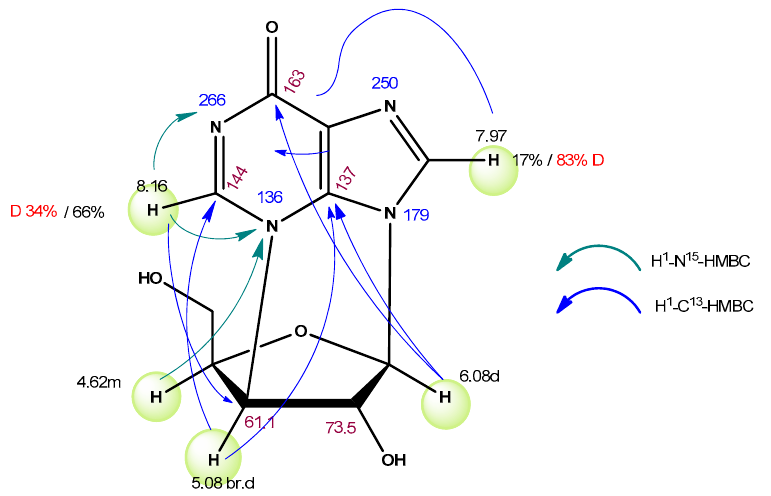
Figure 10. Assignments of main NMR signals for compound 12 .